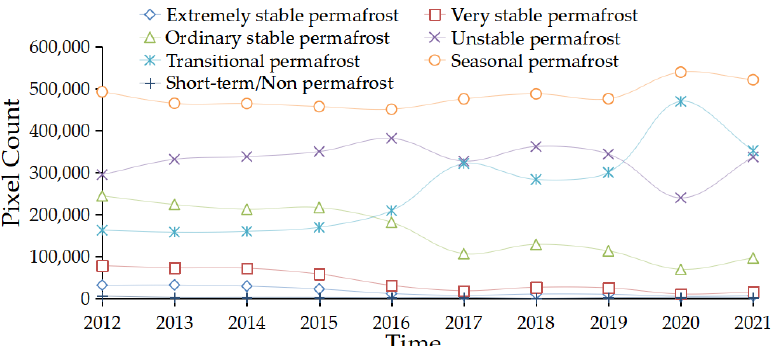
Figure 14. Total count of pixels for each class (extremely stable, very stable, ordinary stable, unstable, transitional, seasonal, and short-term/non-permafrost) for each year from 2012 to 2021.